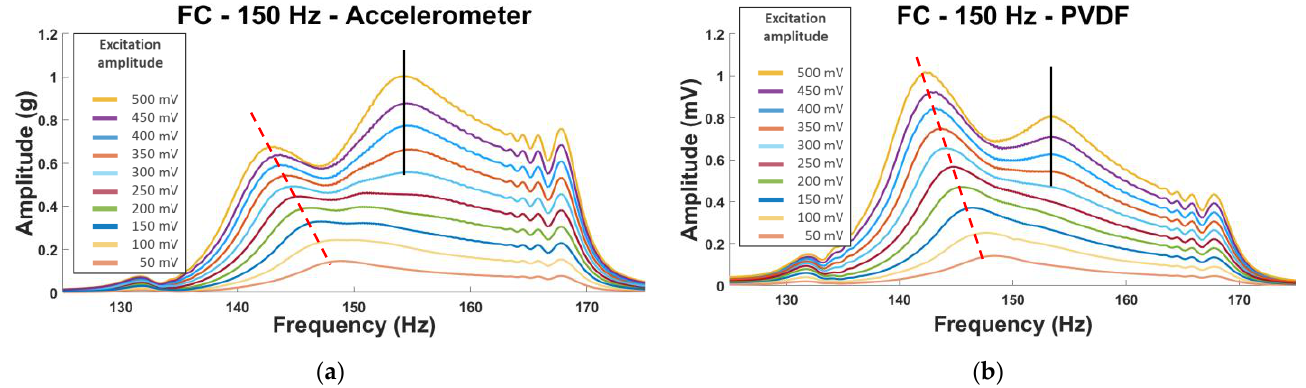
The fiber cutting (FC plate) seemed to influence the vibration of the second and the fifth modes while the two delaminations (DM and DS plates) seemed to influence the fourth mode, especially DM. The second mode was investigated for the FC plate, and an interesting phenomenon was observed. Two peaks are observable for this mode with one showing a big shift in frequency, a loss around 5 Hz (Figure 11); this phenomenon is observable for both sensors and every repeated test. The second peak is observable for the sixth level of excitation (300 mV) and higher, which means the plate does not show this nonlinear behavior at a low amplitude of excitation.